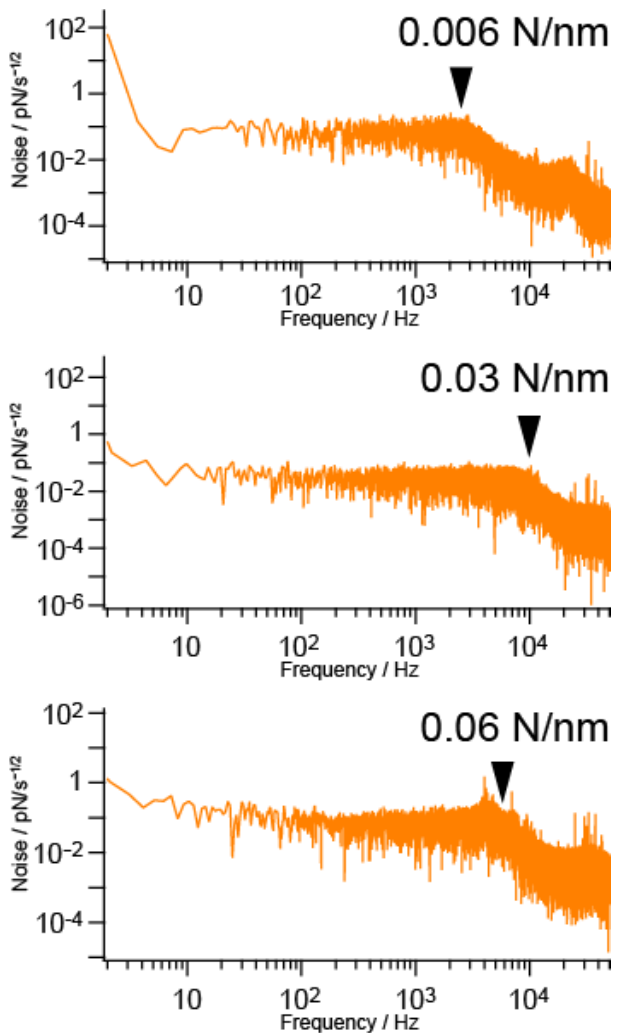
Figure 3. Power spectra of the three cantilevers with spring constants of 0.006 N/m, 0.03 N/m and 0.06 N/m, whose cutoff frequencies were estimated to be 2 kHz, 10 kHz and 5 kHz,